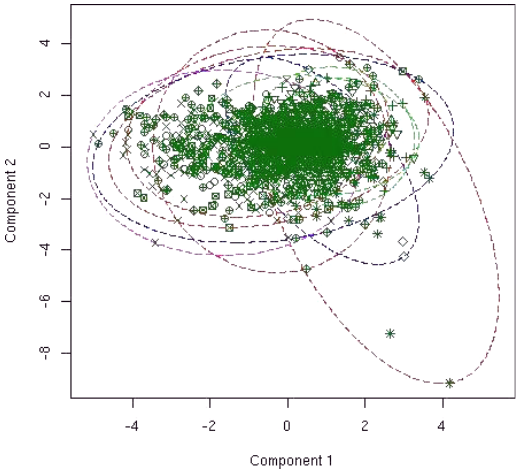
Fig. 3. Size of Clusters by KEFCM wd .